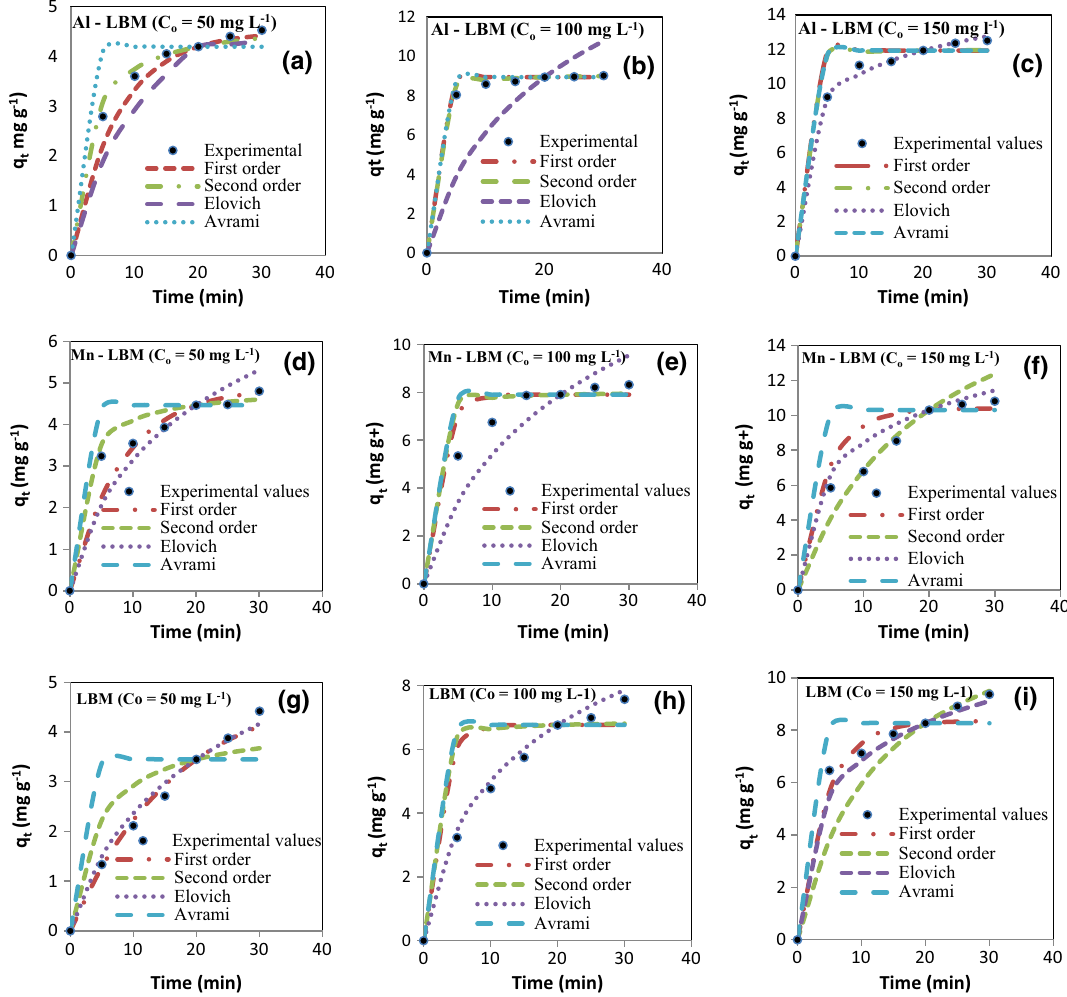
Fig. 3 Fits of the kinetic models at initial concentration of 50, 100 and 150 mg L −1 for Al-LBM ( a – c ), Mn-LBM ( d – f ) and LBM ( g – i